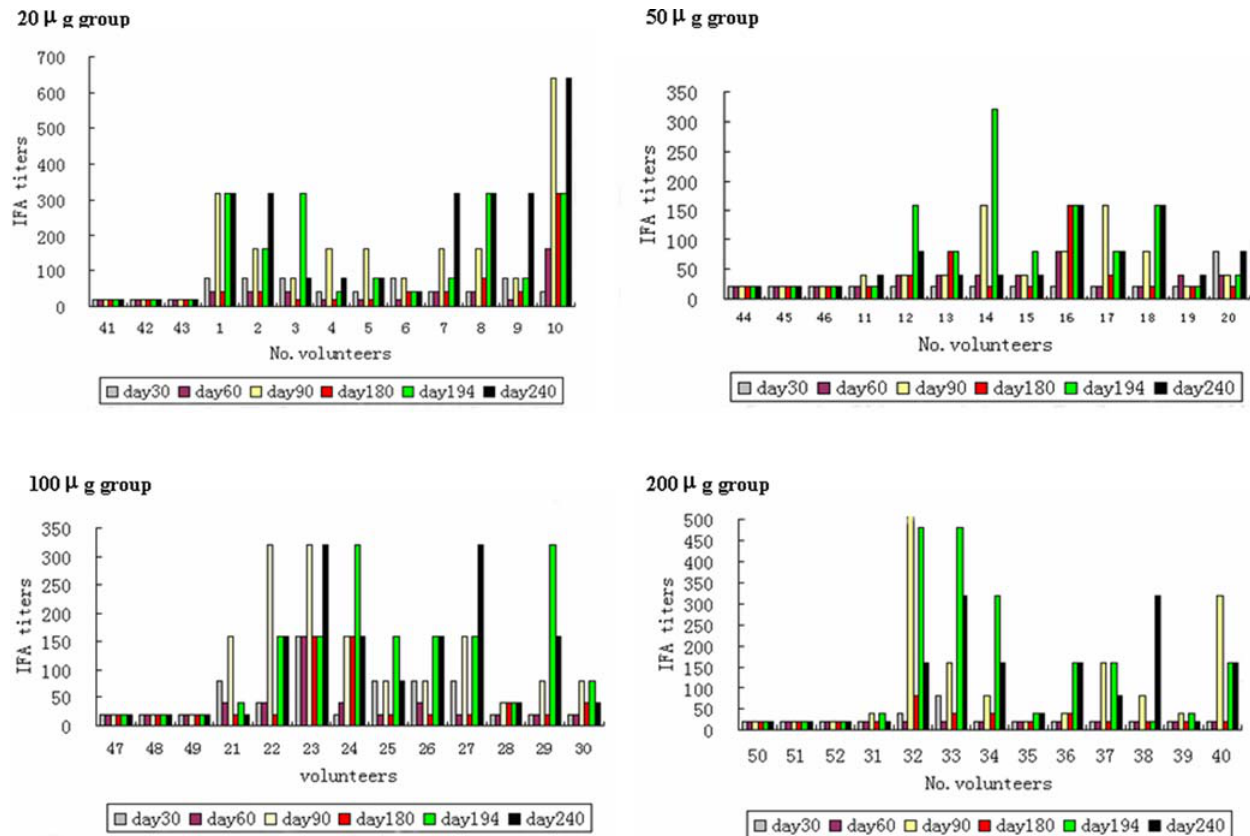
Figure 2. Antibody response to the cultured parasite measured by IFA in sera from participants in groups receiving 20 m g, 50 m g, 100 m g and 200 m g of the test vaccine formulation and the placebo, respectively. The IFA titers in sera collected from the days 30, 60, 80, 180, 194 and 240 were indicated by different symbols. The x-axis is the volunteer’s consecutive number: No.1 , 10 receiving 20 m g, No.11 , 20 receiving 50 m g, No.21 , 30 receiving 1000 m g, and No.31 , 40 receiving 200 m g of the vaccine while No.41 , 52 receiving the placebo.